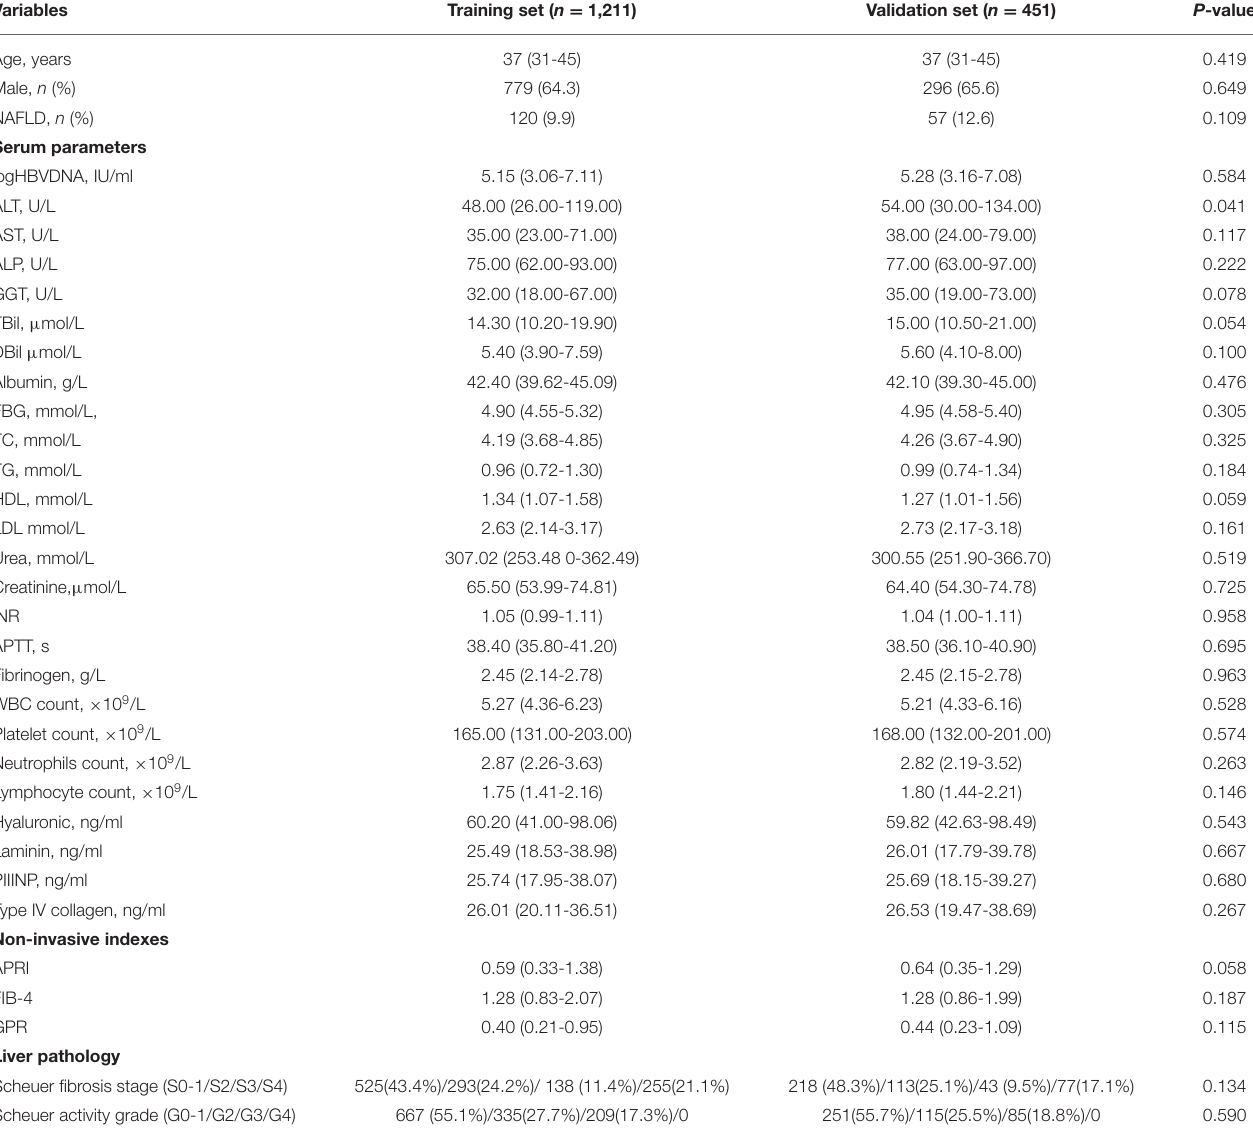
TABLE 1 | Clinical characteristics of studied patients with